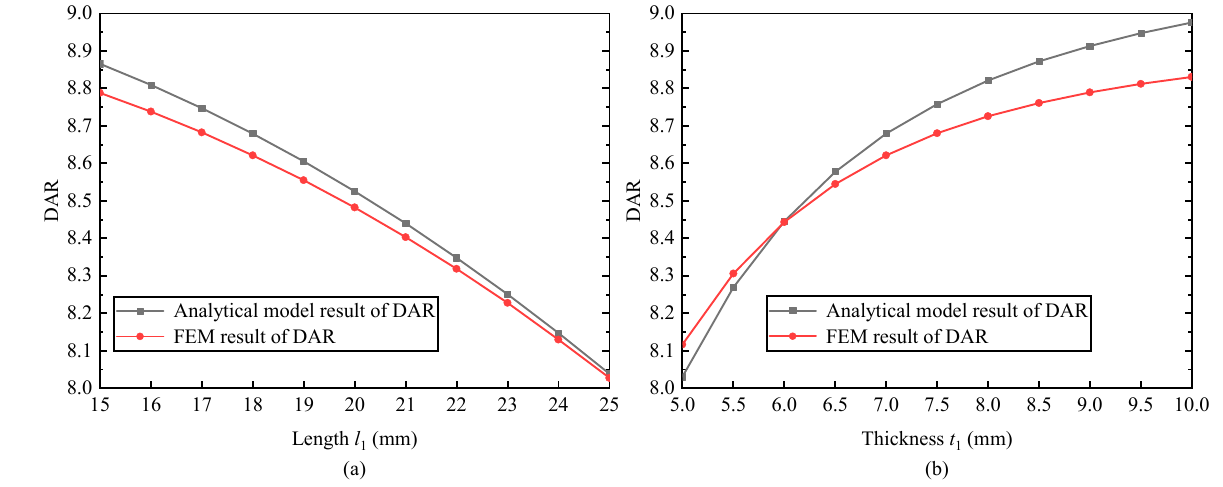
Figure 6. The changes in DAR with the input body varied. ( a ) The input body length l 1 . ( b ) The input body thickness t 1 .